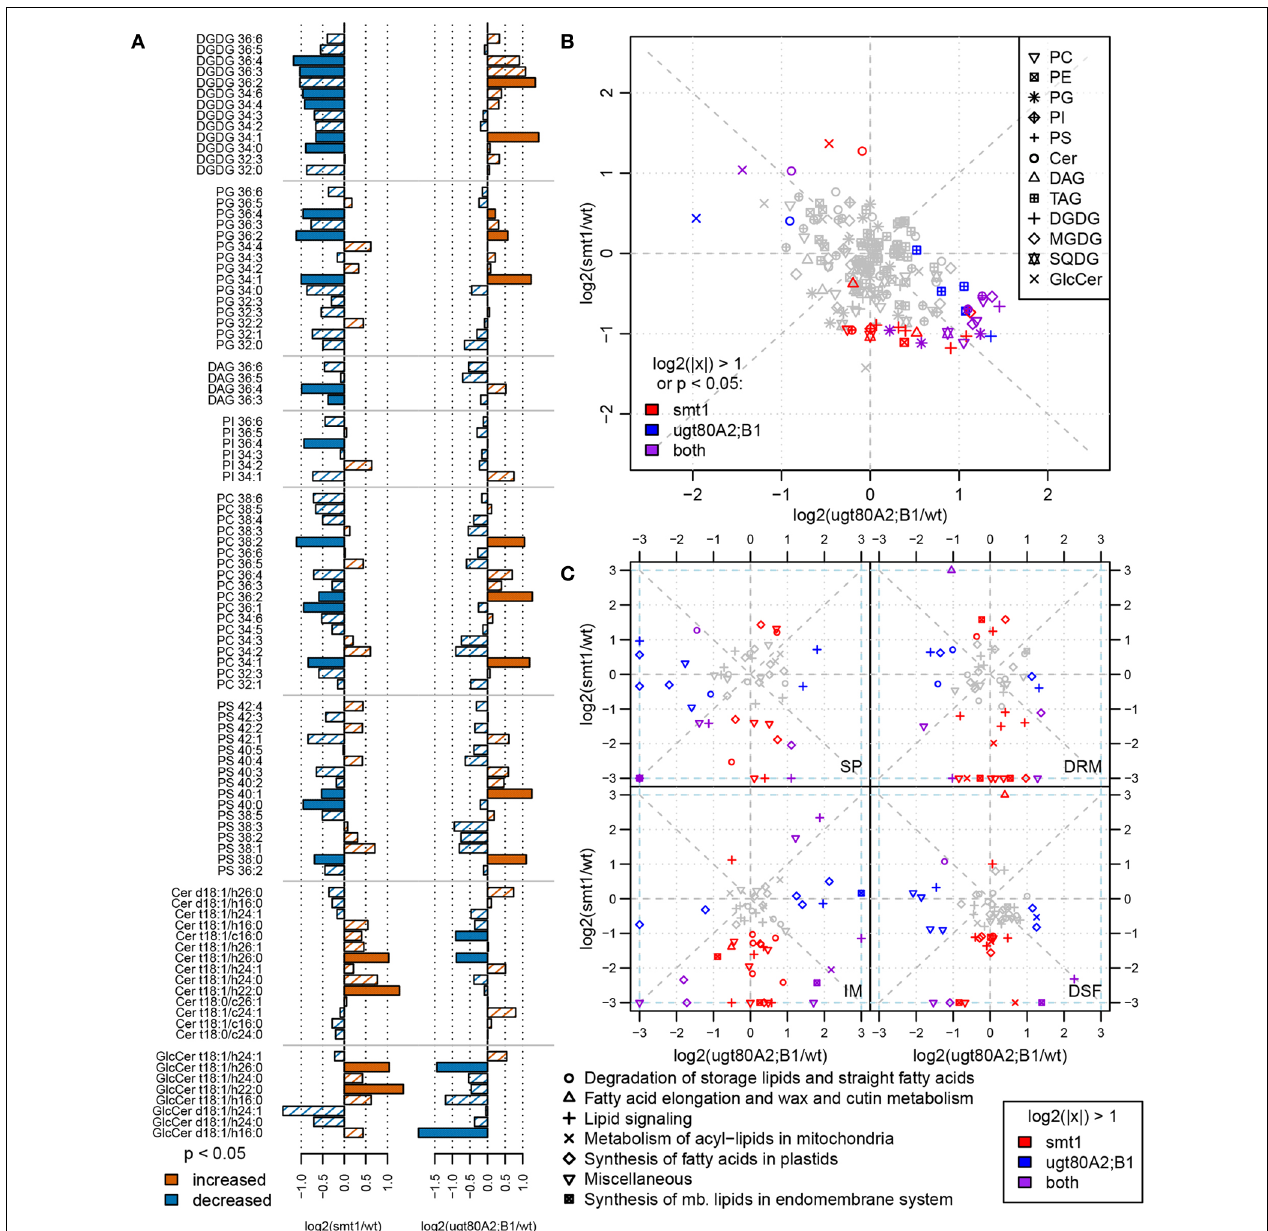
FIGURE 3 | Comparison of log 2 transformed lipid abundances from smt1 and ugt80A2;B1 related to wildtype (A). Lipids with a higher-than two-fold change or significant difference in abundance ( t -test; α < 0 . 05) are colored as indicated in the legend. Lipid abundance changes of smt1 and ugt80A2;B1 relative to wildtype display a generally inverse pattern (B) . Specific changes in proteins involved in lipid metabolism correlate with lipid distributions in respective fractions (IM, SP, DRM, DSF) (C) . Isomer forms of detected